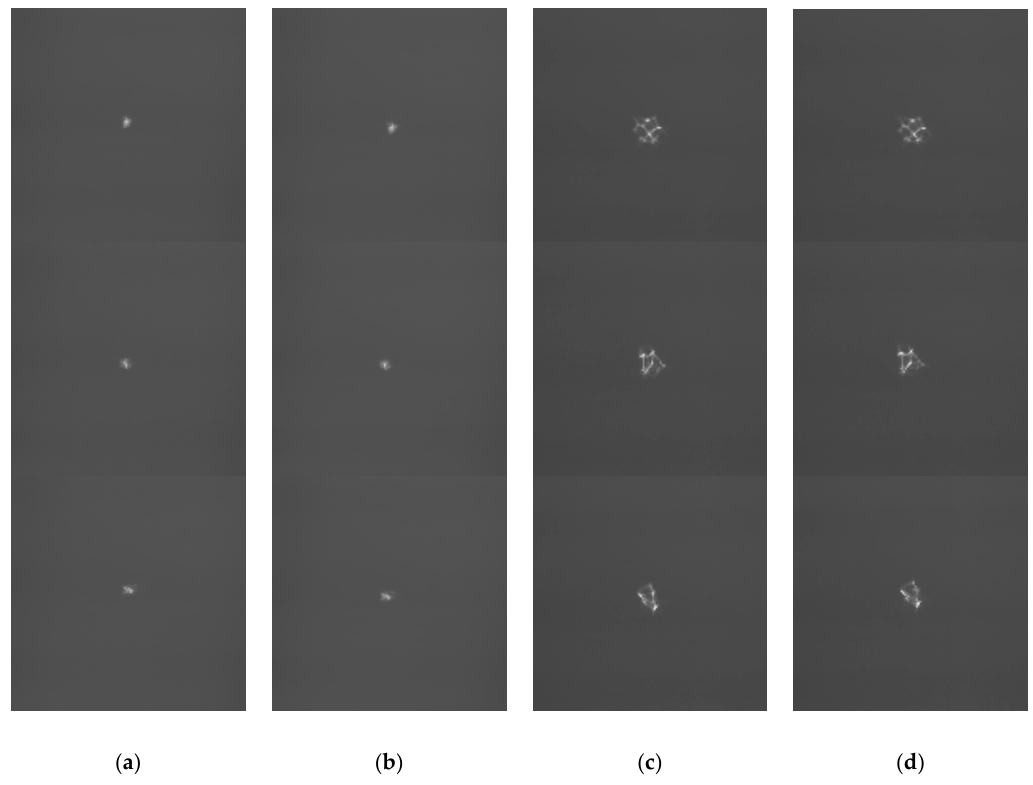
Figure 10. PSF images of ( a ) the initial in focus plane; ( b ) the in focus plane by the De-VGG predicted; ( c ) the initial defocus plane; ( d ) the defocus plane by the De-VGG predicted for D/𝑟 (cid:2868) = 20.